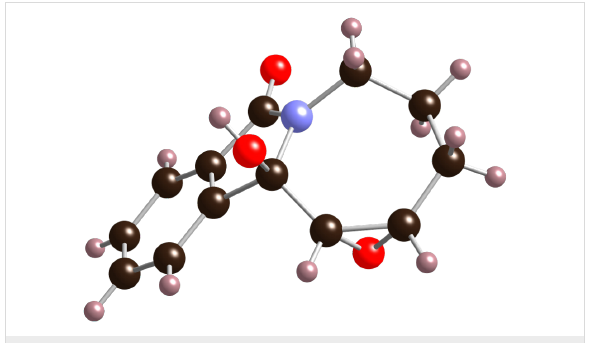
Figure 4: X-Ray structure of epoxyalcohol 6